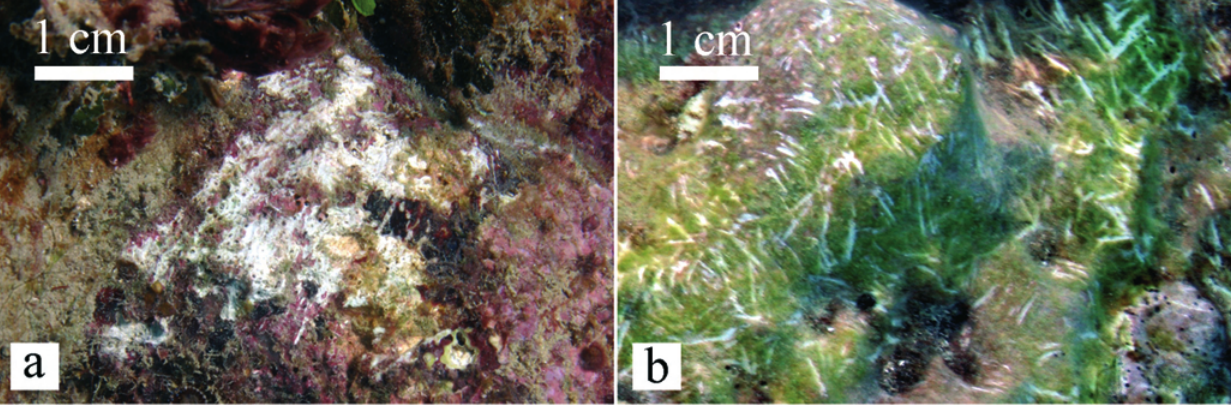
Fig. 6. (a) Scars caused by large individuals (> 40 cm TL) and (b) scrapes caused by small individuals (20-40 cm TL) of Scarus trispinosus on crustose calcareous